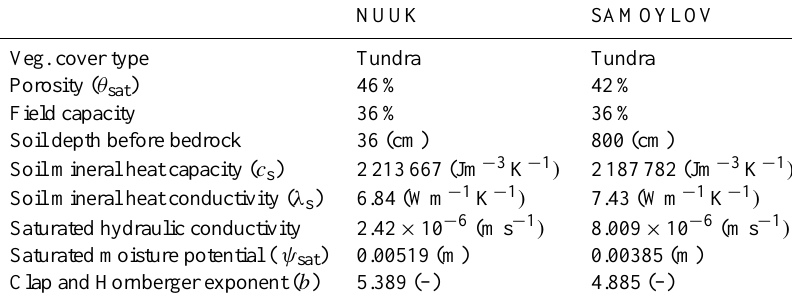
Table 1. JSBACH model parameters used in the site